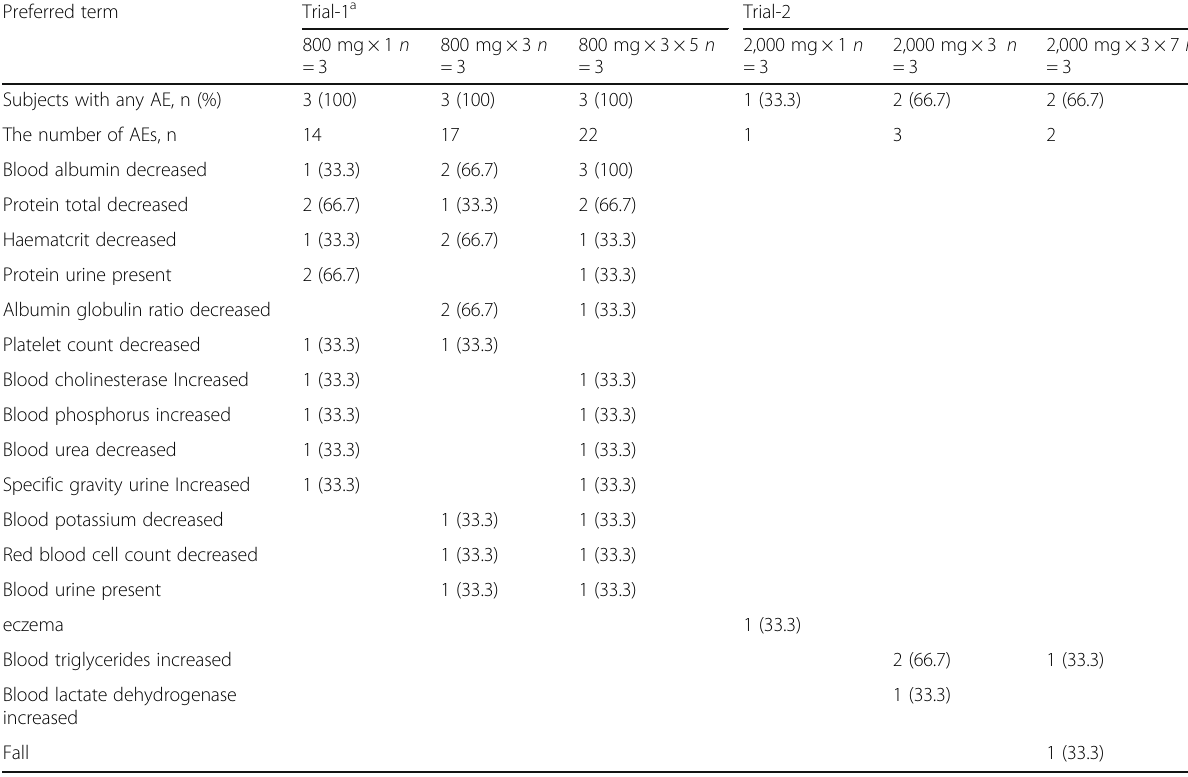
Table 3 Summary of adverse events in Trial-1 and Trial-2 Preferred term Trial-1